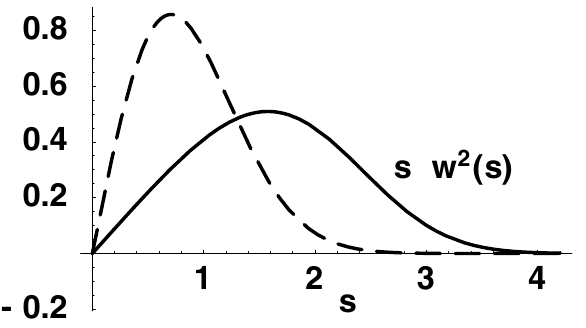
FIG. 2. The radial distribution sw 2 (cid:2) s (cid:3) compared with the distribution in absence of space charge (dashed line). The space-charge strength is (cid:7) (cid:21) 11 : 2 . All quantities are dimensionless.